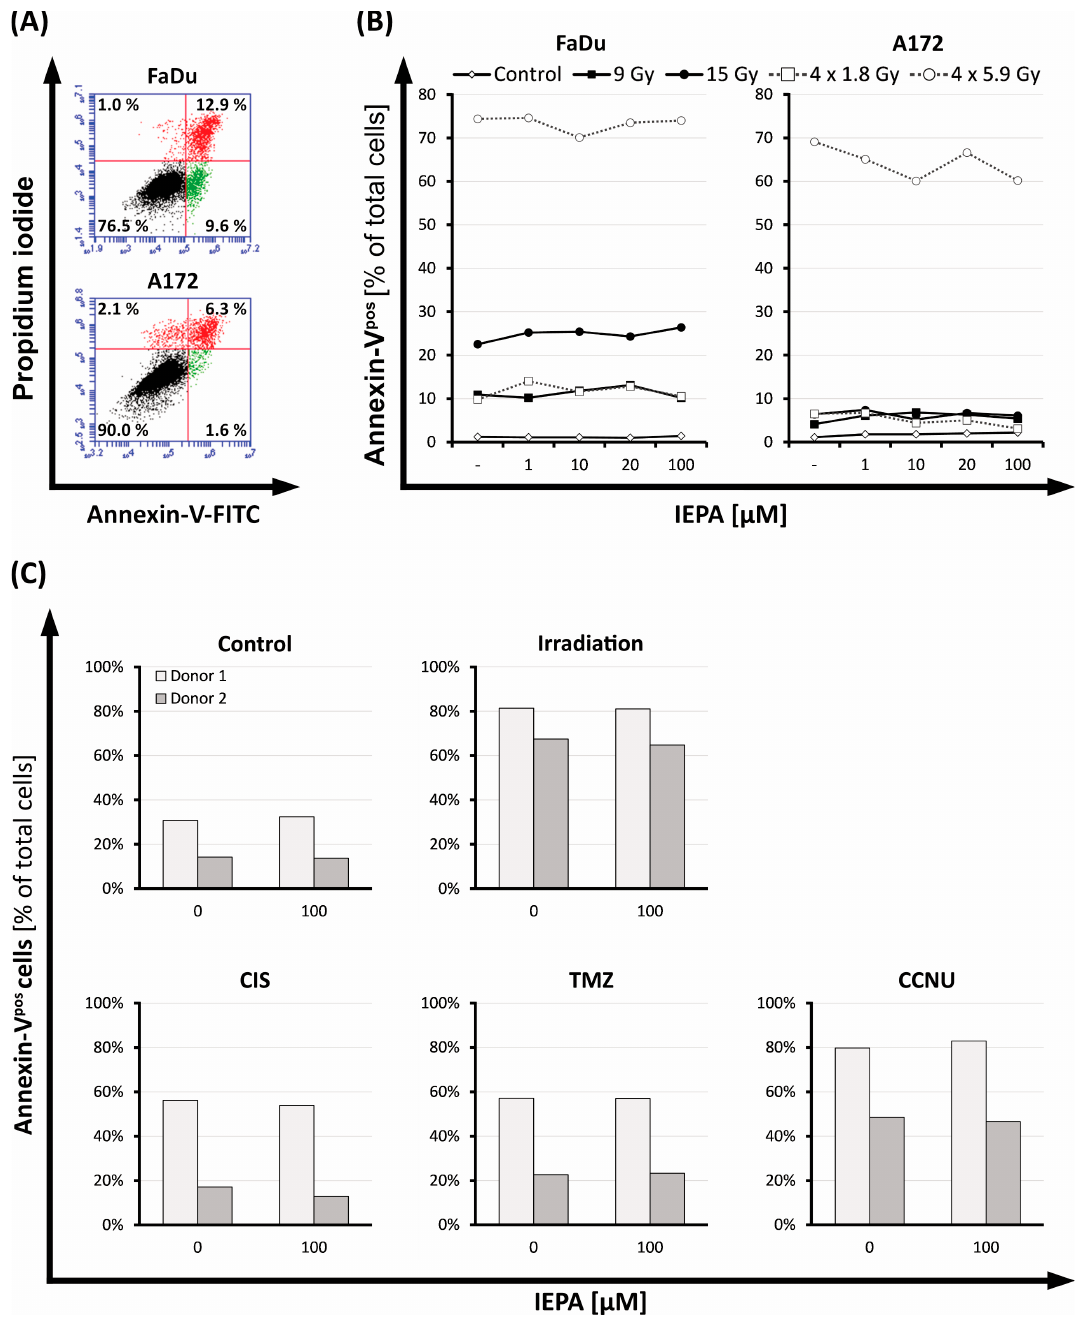
Figure 3. ( A ) Flow-cytometric dot plot of FaDu and A172 cells 72 h after IR (15 Gy), partitioned into vital cells (Annexin-V neg PI neg , lower left quadrant), apoptotic cells (early apoptotic: Annexin-V pos PI neg , lower right quadrant; late apoptotic: Annexin-V pos PI pos , upper right quadrant), and necrotic cells (Annexin-V neg PI pos , upper left quadrant). ( B ) Fraction of apoptotic cells (Annexin-V pos ) in FaDu and A172 cells 72 h after IR in various regimens (single-dose: 9, 15 Gy; fractionated: 4 × 1.8, 4 × 5.9 Gy); treatment with IEPA compared with representative untreated control (sham-RT). ( C ) Fraction of apoptotic cells (Annexin-V pos ) in CD34 + HSPCs 72 h after IR (3.2 Gy, single-dose), treatment with CIS (1 µM), TMZ (40 µM), or CCNU (60 µM), and application of IEPA (100 µM) compared with sham treatment.